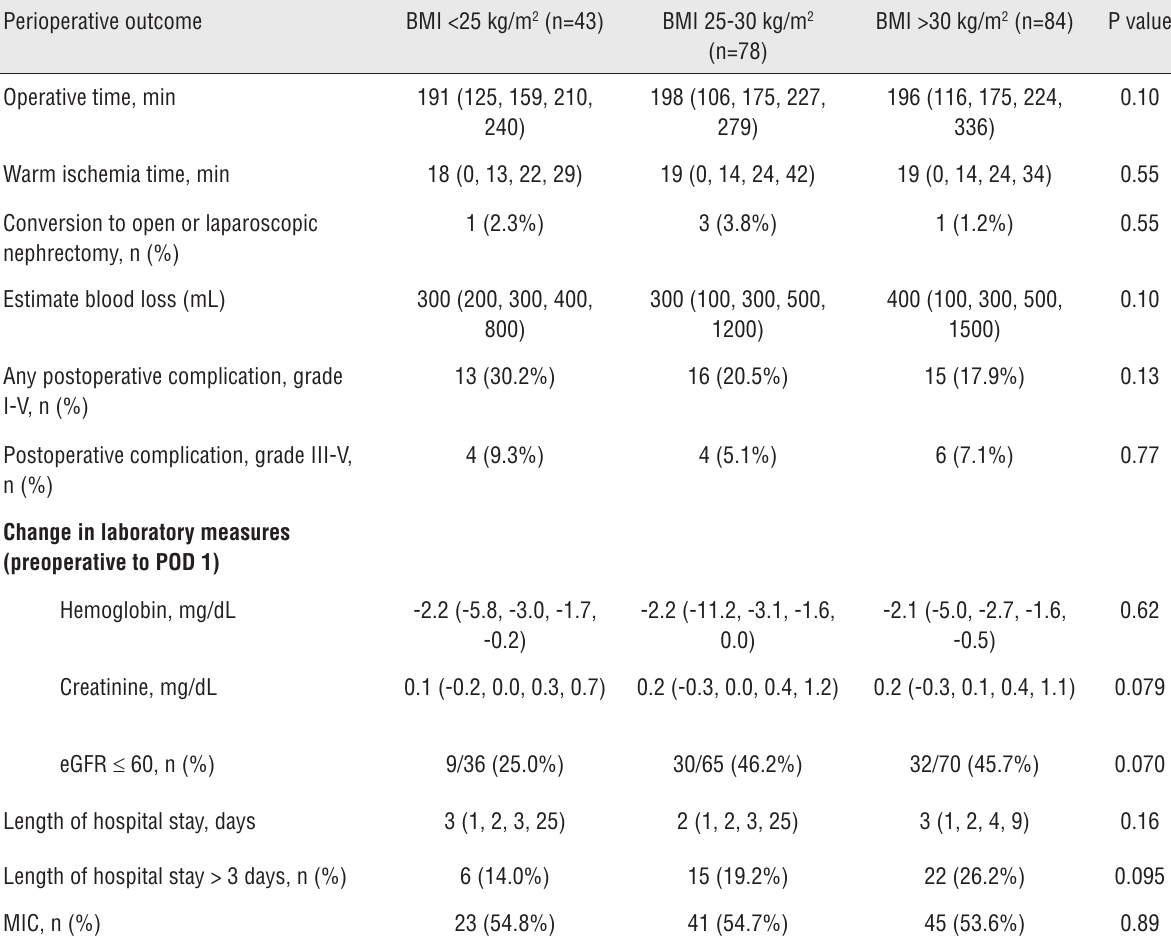
Table 3 - Perioperative outcomes according to body mass